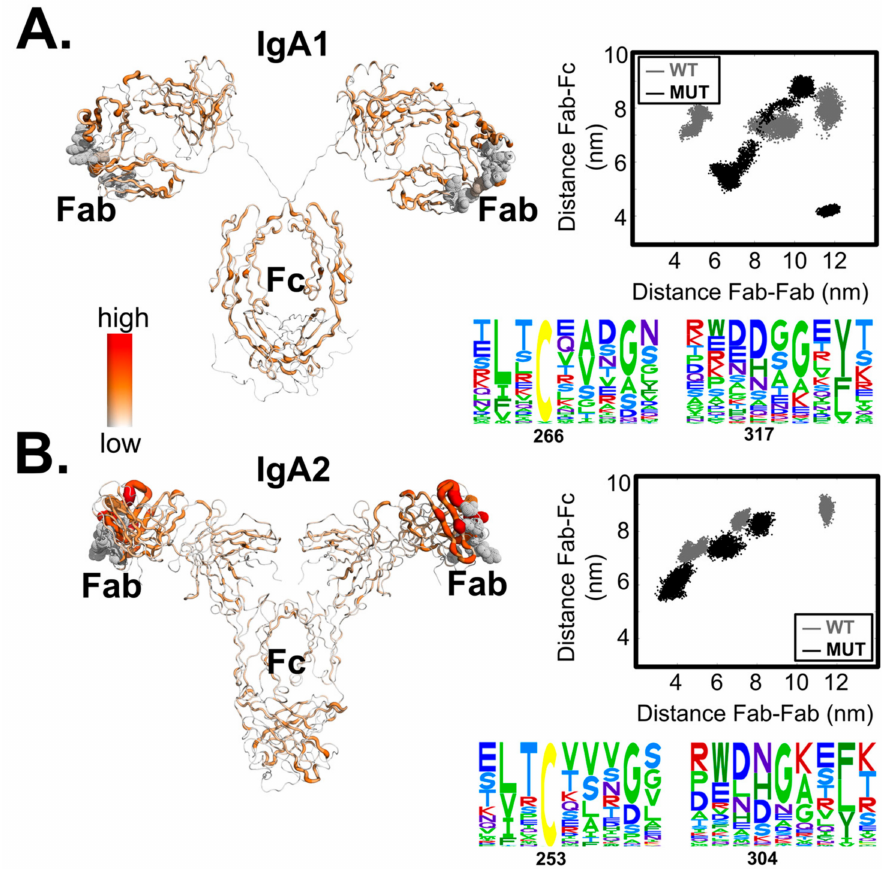
Figure 2. Residue couplings and hinge-dependent domain proximity of the two variants IgA1 (in A ) and IgA2 (in B ). The sequence alignments of the mutation regions were performed using the EVcoupling server [39] and the coupling values were mapped back to the minimized structures of the variants. Distances were estimated between the centre of mass of the Fc region and that of the Her2-binding sites. Note that in the distance distributions of the IgA2 mutant (in B ) showed the plotted values obtained from two replicates that successfully reached equilibrium in the given time